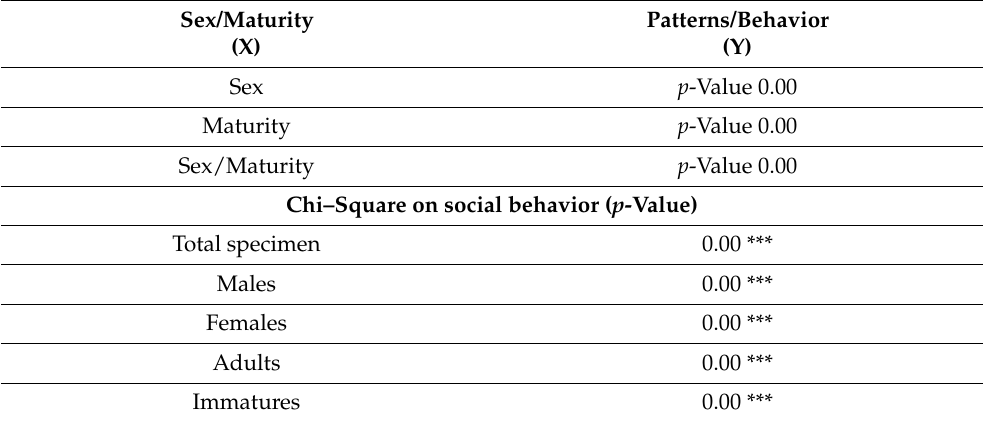
Table 1. Chi-square test. Table on the left refers to the test addressing the two pairs of variables. The χ 2 ’s test statistics are 78.43 (Sex); 87.24 (Maturity); 63.69 (Sex/Maturity). The table on the right refers to the test addressed for every variable accounted for. The χ 2 ’s test statistics are 63.21 (Males/Adults); 65.17 (Males/Immatures); 73.61 (Females/Adults); 84.19 (Females/Immatures). The significance codes stand for: *** significance at 1%, ** significance at 5%, * significance at